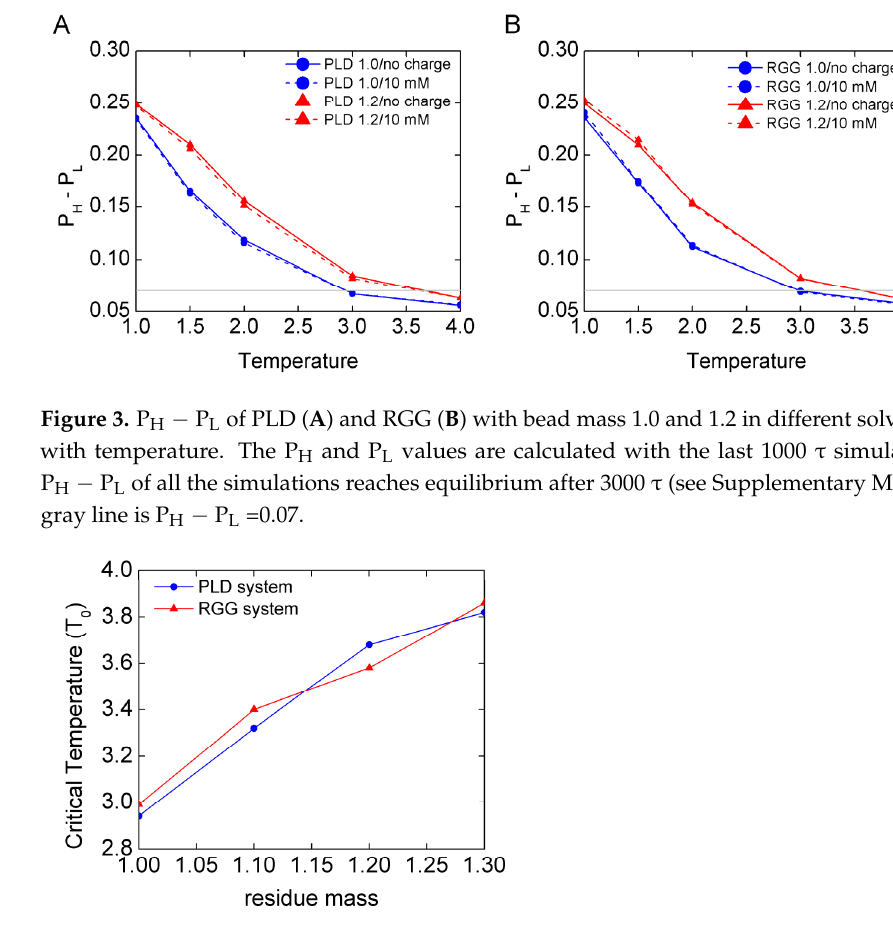
Figure 4. Critical temperature ( T Cr ) of LLPS changes with PLD system mass or RGG system mass.